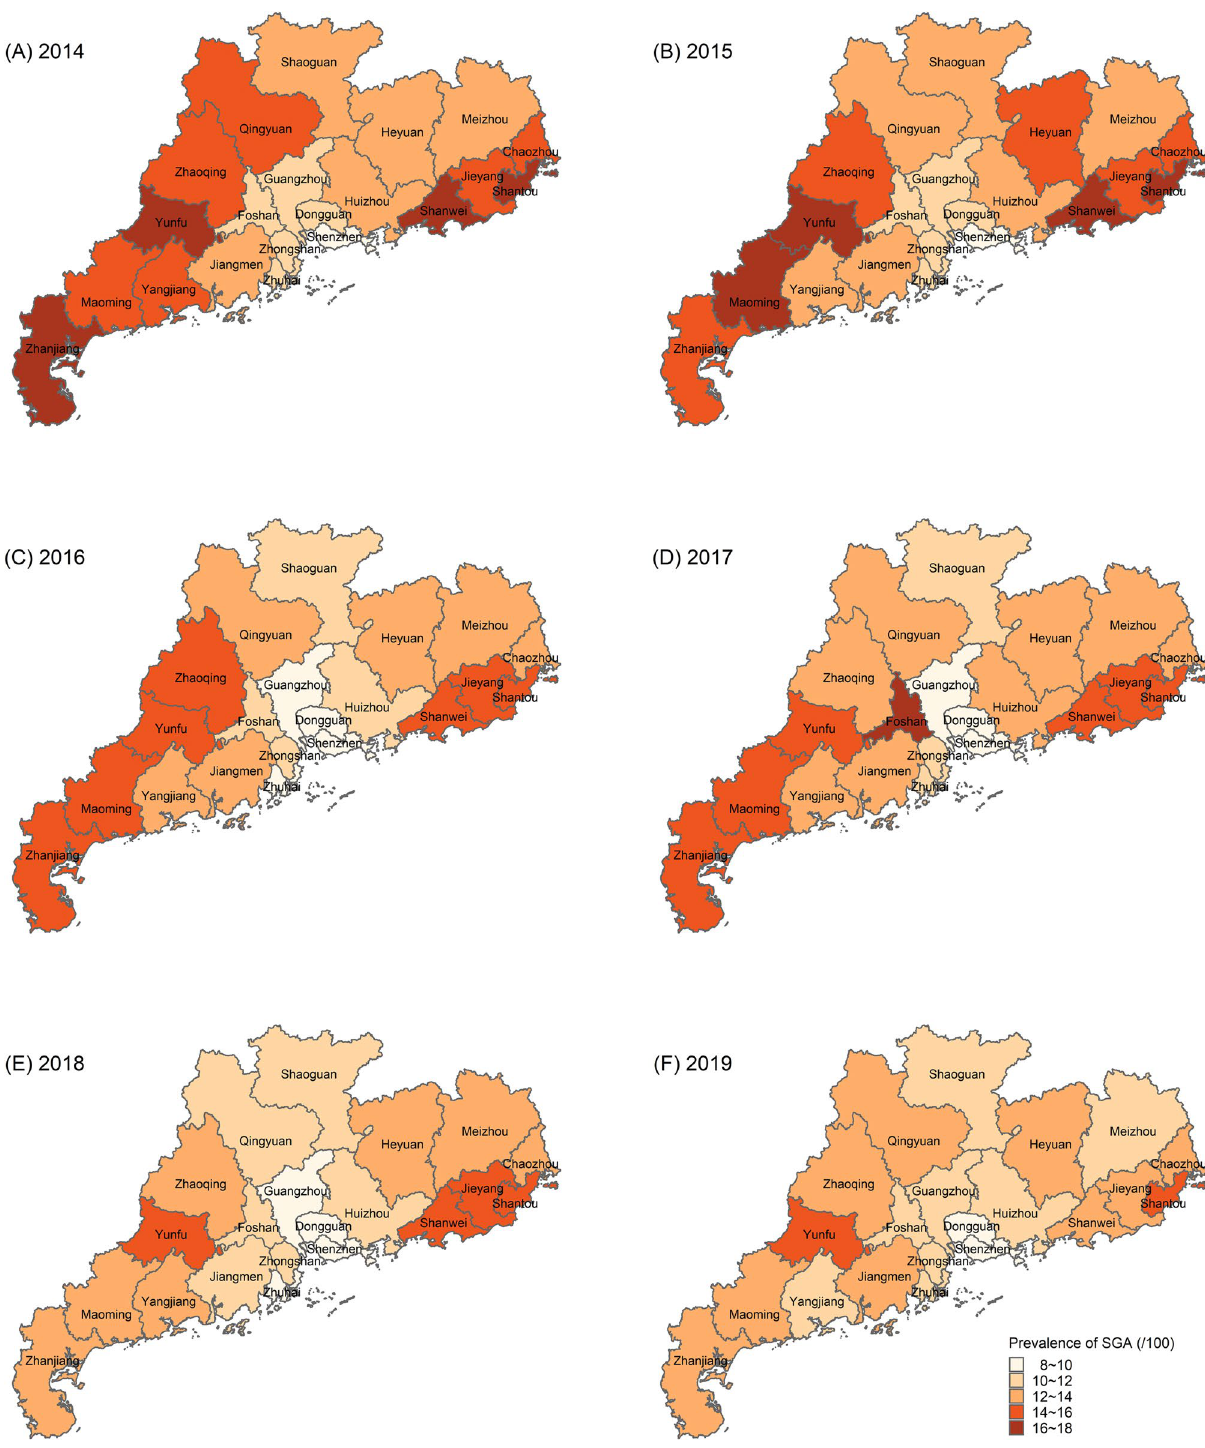
Figure 2. Regional Distribution of SGA prevalence in Guangdong Province, China from 2014 to 2019. ( A ) Regional distribution of SGA prevalence in 2014. ( B ) Regional distribution of SGA prevalence in 2015. ( C ) Regional distribution of SGA prevalence in 2016. ( D ) Regional distribution of SGA prevalence in 2017. ( E ) Regional distribution of SGA prevalence in 2018. ( F ) Regional distribution of SGA prevalence in